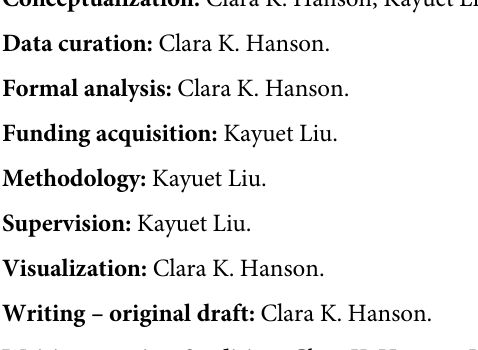
S3 Table. Distribution of demographic and attitudinal variables across dependent vari- ables. S4 Table. Interactions between key demographic traits and Party ID on dependent vari- ables. S1 Fig. Conditions for prosocial message experiment. S2 Fig. Conditions for disease spread message experiment. S3 Fig. Conditions for hardship message